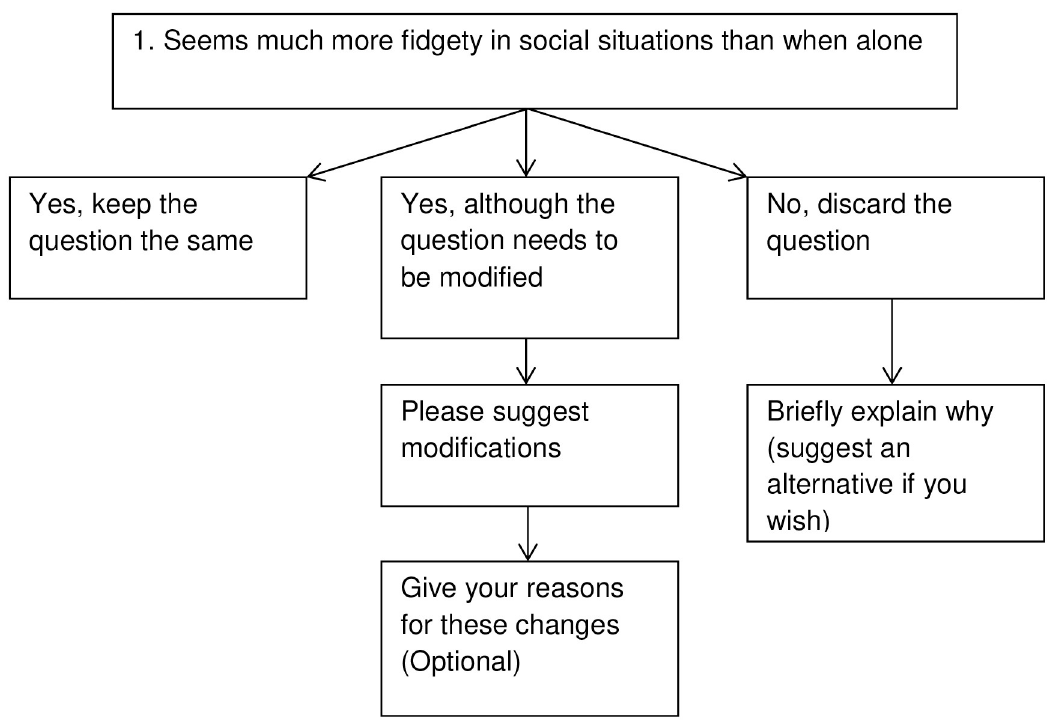
Fig 1. Flowchart illustrating example response options presented with each SRS-2 item.